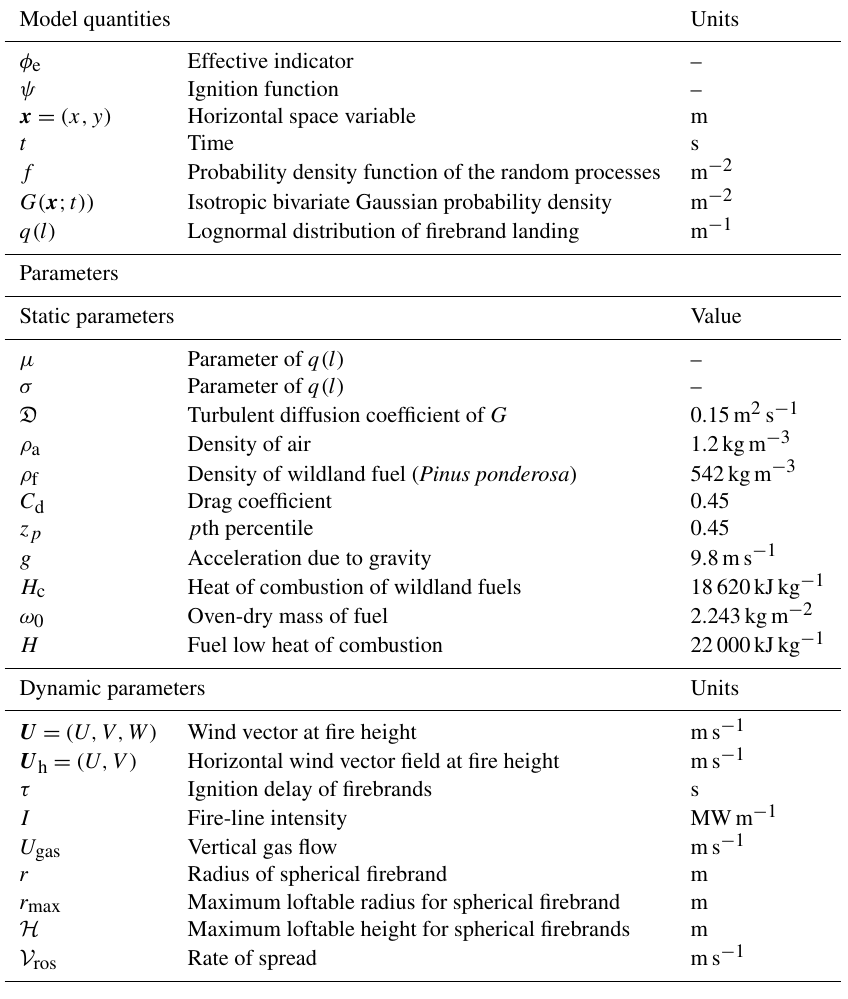
Table 1. List of the symbols used to describe the model quantities and the parameters used in this study. Model quantities Units φ e Effective indicator – ψ Ignition function – x = (x,y) Probability density function of the random processes